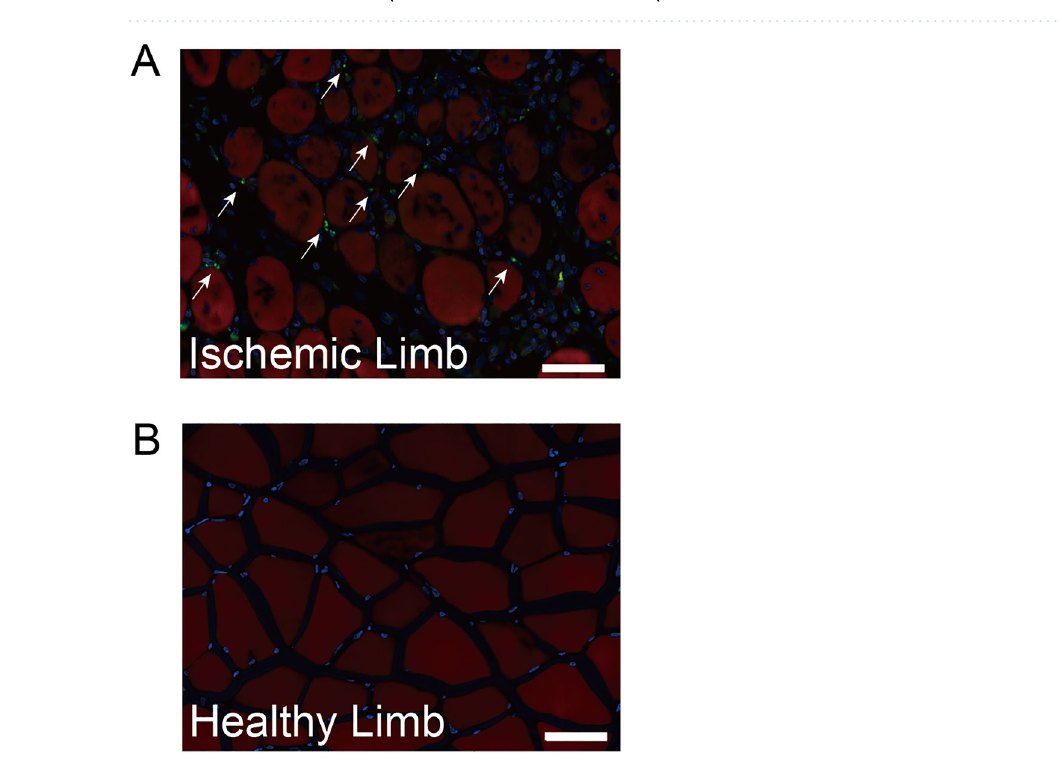
Figure 3. Histological assessment of rat ischemic limb tissues 1 day after GFP-MSC infusion. (A) In the cell group, infused GFP-MSCs (green) were detected in the ischemic hindlimb after counterstaining with phalloidin (red) and DAPI (blue). (B) In the control group, no green cells were found. Scale bars indicate 50